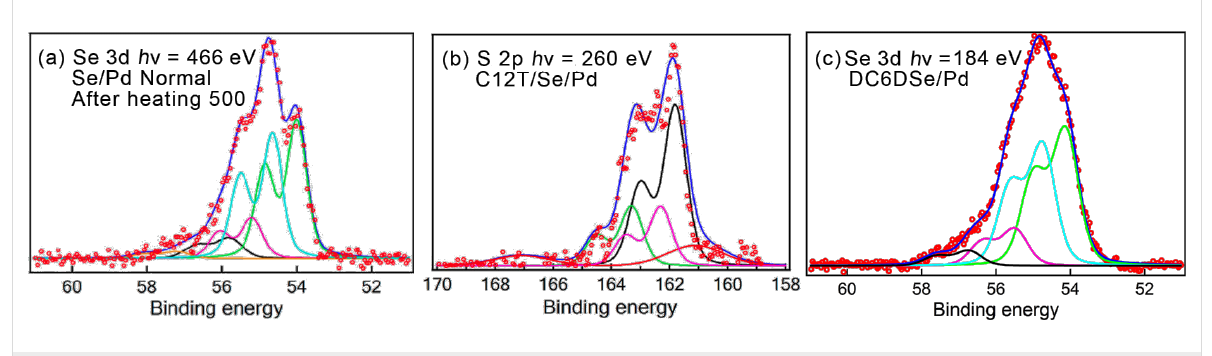
Figure 4: (a) XPS in the Se 3d region [48] after initial selenization of Pd with atomic selenium and heating to 500 °C. (b) XPS spectrum [48] in the S 2p region after C12T adsorption on the selenized surface (see text). (c) XPS in the Se 3d region after adsorption of DC6DSe (this work). Figure adapted with permission from [48], copyright 2014 American Chemical